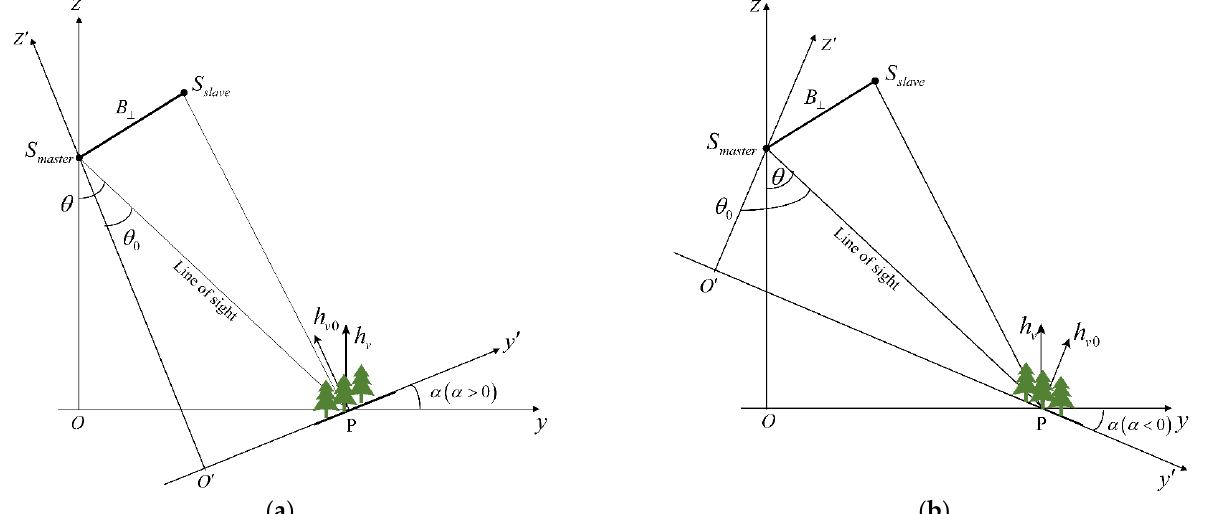
Figure 6. The geometric model of forest scattering is affected by terrain slope. ( a ) The landscape distribution faces the radar sensor when the terrain slope is positive. ( b ) When the terrain slope is negative, the landscape distribution is at the back of the radar sensor. yoz and y (cid:48) o (cid:48) z (cid:48) are the coordinate system under flat terrain and the slope-corrected coordinate system, respectively. B ⊥ means the vertical baseline. S master and S slave are the master image and the slave image, respectively. P is the ground object (e.g., forest), θ is the radar incidence angle, θ 0 is the local incidence angle, α is the range slope, h v 0 is the slope-corrected forest height under the y (cid:48) o (cid:48) z (cid:48) coordinate system, and h v is the forest height under the yoz coordinate system.